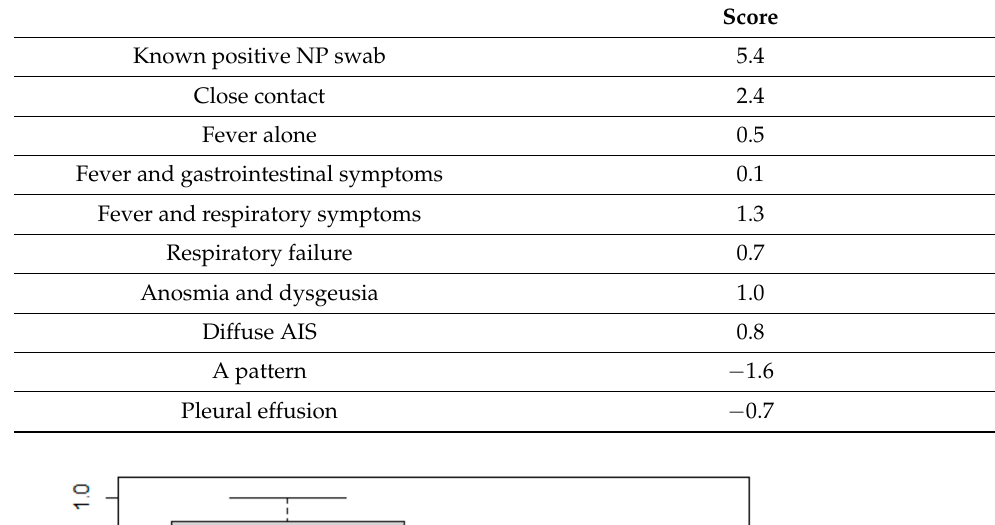
Table 4. Results from the logistic regression analysis: coefficients on the log-odd scale and associ- ated standard errors, significance tests. NP, nasopharyngeal. AIS, alveolar-interstitial syndrome. Significance codes: 0 ‘***’ 0.001 ‘**’ 0.01 ‘*’ 0.05 ‘.’ 0.1 ‘ ’ 1.